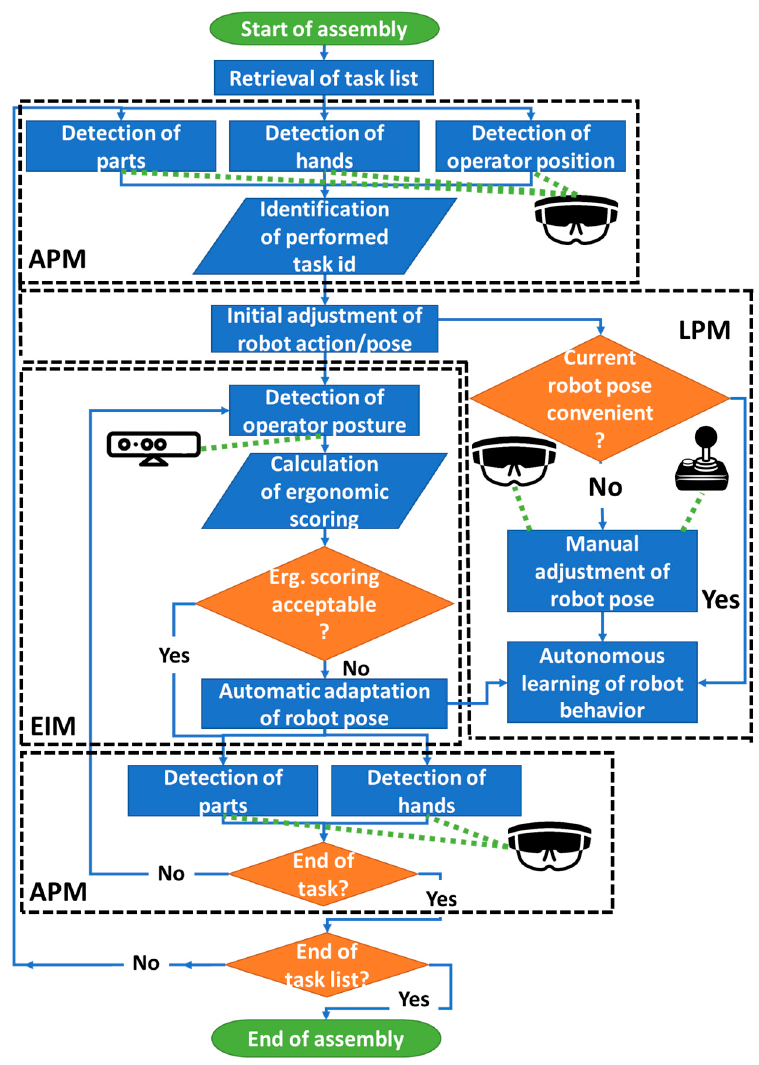
Figure 2. Flowchart of the seamless HR collaborative assembly paradigm.